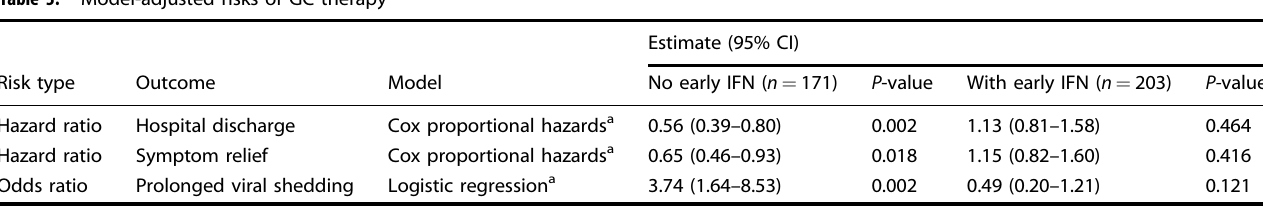
Table 3. Model-adjusted risks of GC